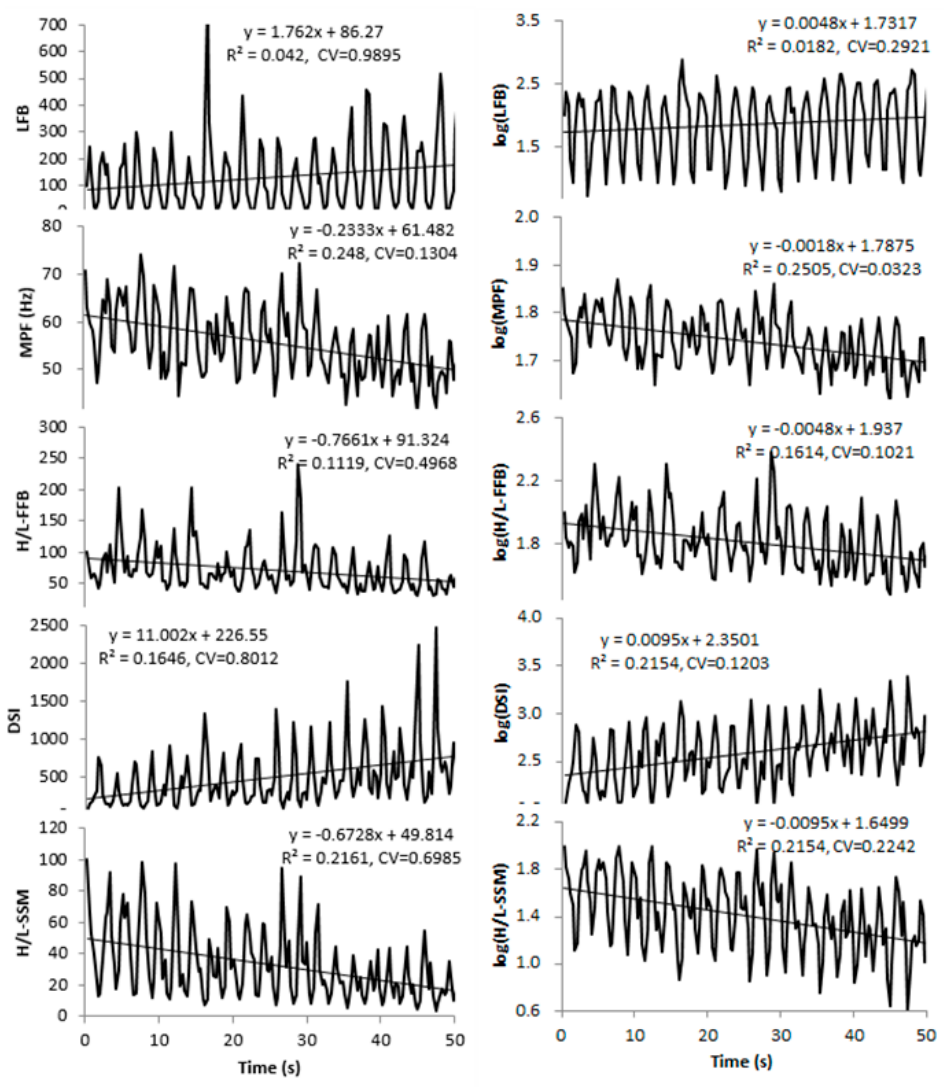
Figure 8. The time series of sEMG parameters during the endurance time (T end ) for the subject whose T end was almost the same as the mean for all measured sEMG of all subjects. The left column ( a ): the five raw parameters; the right column ( b ): the five logarithmic parameters; R2: coefficient of determination; CV: coefficient of variation.